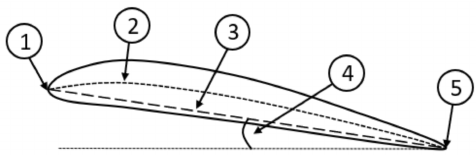
Figure 8. Wing section nomenclature [29]. 1: Leading edge. 2: Medium line. 3: Chord line. 4: Angle of attack. 5: Trailing